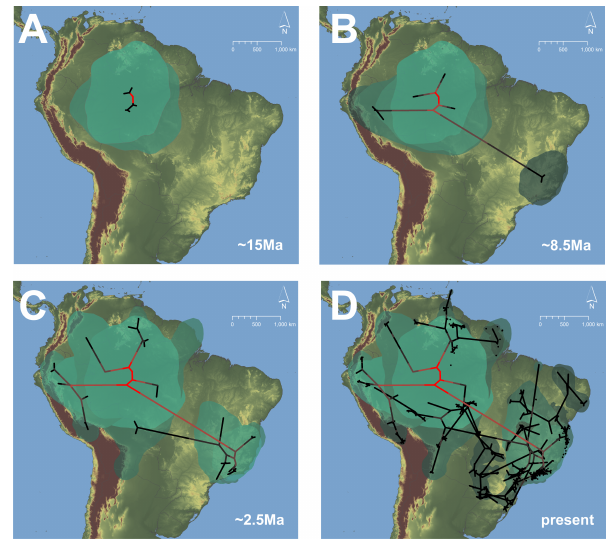
Figure 5. Phylogeographic reconstruction of Dendropsophus minutus group. Phylogeographical analysis of the Dendropsophus minutus group based on the 16S + COI mitochondrial dataset using a Relaxed Random Walk model for continuous trait reconstruction in Beast software. A) center of origin of the D. minutus group. B) Dispersal to west Amazonia, Guiana Shield, Andean region of Peru and eastern Brazil; polygon at the east represent the geographic origin of lineages representing the D. minutu s complex. C) Dispersal from east Brazil to lowland of Bolivia; further dispersal to Guiana Shield, Peruvian and Colombian areas. D) Recent dispersals to northeast and south Brazil, east Paraguay and Guiana shield. Green polygons and red branches indicate relatively older events while dark polygons and black branches indicate later events. Maps were generated using google earth